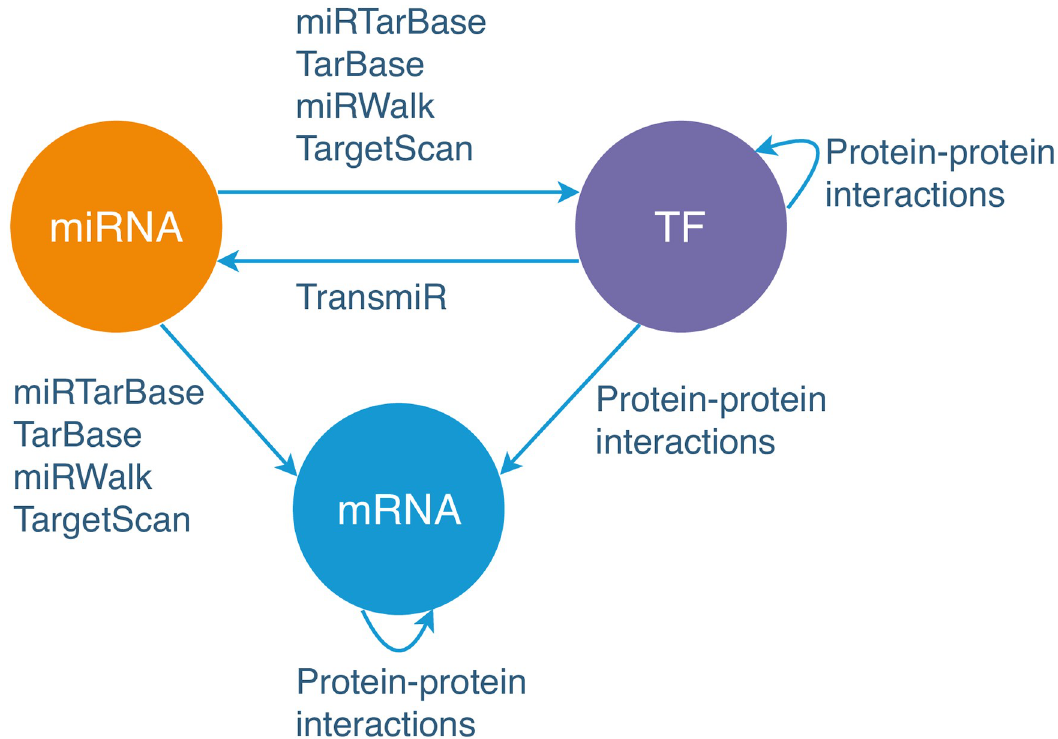
Fig 3. Determining the directions of edges in the miRNA-TF-mRNA regulatory network. In a miRNA-TF-mRNA regulatory network, miRNAs can regulate TFs and mRNAs, TFs can regulate miRNAs and mRNAs, TFs/mRNAs can regulate other TFs/ mRNAs. This motif is adapted from the work of [66]. In addition, the databases used to filter out edges of the network are shown on arrows.